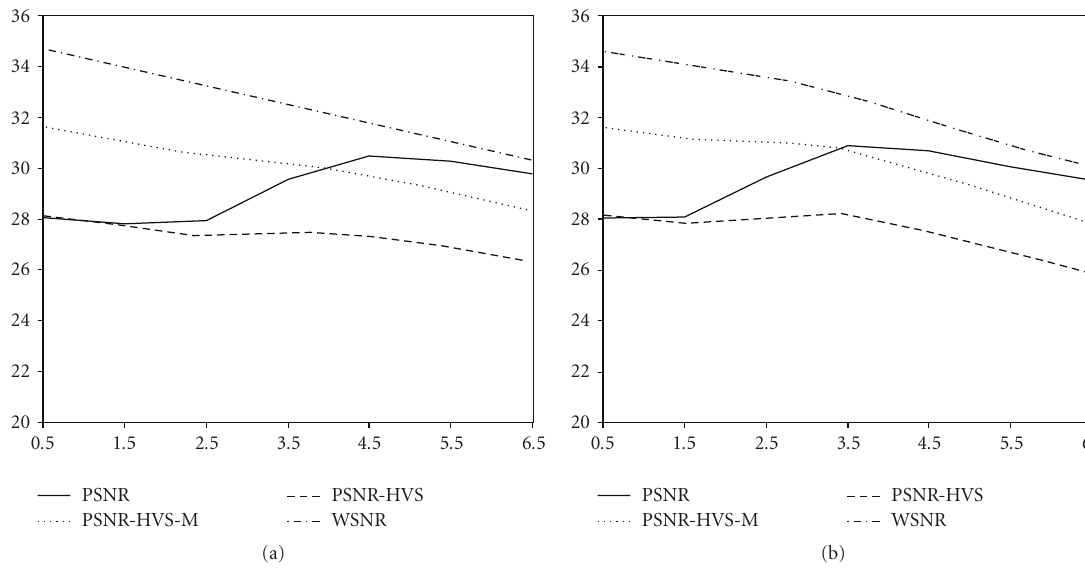
Figure 4: Dependencies of metrics on b for the image Goldhill, σ 2 = 100, for the coders AGU (a) and ADCTC (b).